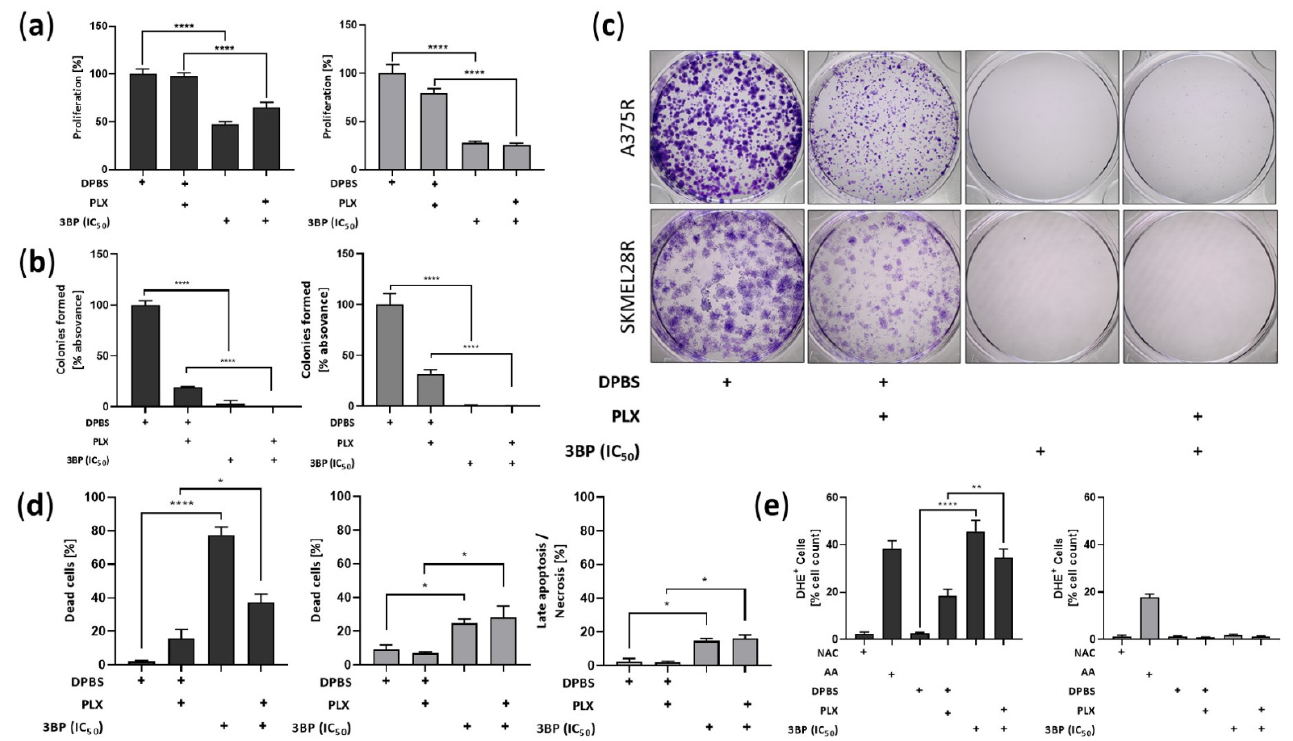
Figure 4. Proliferation, colony formation, cell death, and reactive oxygen species (ROS) production analysis in vemurafenib (PLX)-resistant melanoma cells treated with 3-bromopyruvate (3BP) for 24 h. PLX-resistant melanoma cells were treated with IC 50 3BP, either alone or combined with PLX (4.5 µM for A375R and 6.0 µM for SKMEL28R), for 24 h. ( a ) Cell proliferation analysis using the 5-bromo-2-deoxyuridine (BrdU) assay. Data were normalized to the vehicle control (100%); ( b ) colony formation analysis in PLX-resistant melanoma cells after violet crystal staining. Graphic representation of absorbance after solubilization of stained cell colonies in acetic acid. Data were normalized to the vehicle control (100%); ( c ) representative PLX-resistant melanoma cell colonies stained with crystal violet; ( d ) cell death analysis using annexin V/propidium iodide (PI) staining. Data representing the statistically significant results obtained by the cell death assay. Early apoptosis: percentage of total cell count annexin V+ and PI − . Late apoptosis/necrosis: percentage of total cell count annexin V − and PI+; ( e ) free radical formation analysis using dihydroethidium (DHE) staining. AA (antimycin A) was used as the positive control; NAC (N-acetylcysteine) was used as the negative control. Data are presented as the percentages of the total DHE+ cell count. Dark gray represents A375R cells; light gray represents SKMEL28R cells. The positive signs in the bar charts indicate the presence of a defined treatment. Data represent the mean ± SEM of at least three independent experiments performed in triplicate. * p ≤ 0.05; ** p ≤ 0.01; **** p ≤ 0.0001.